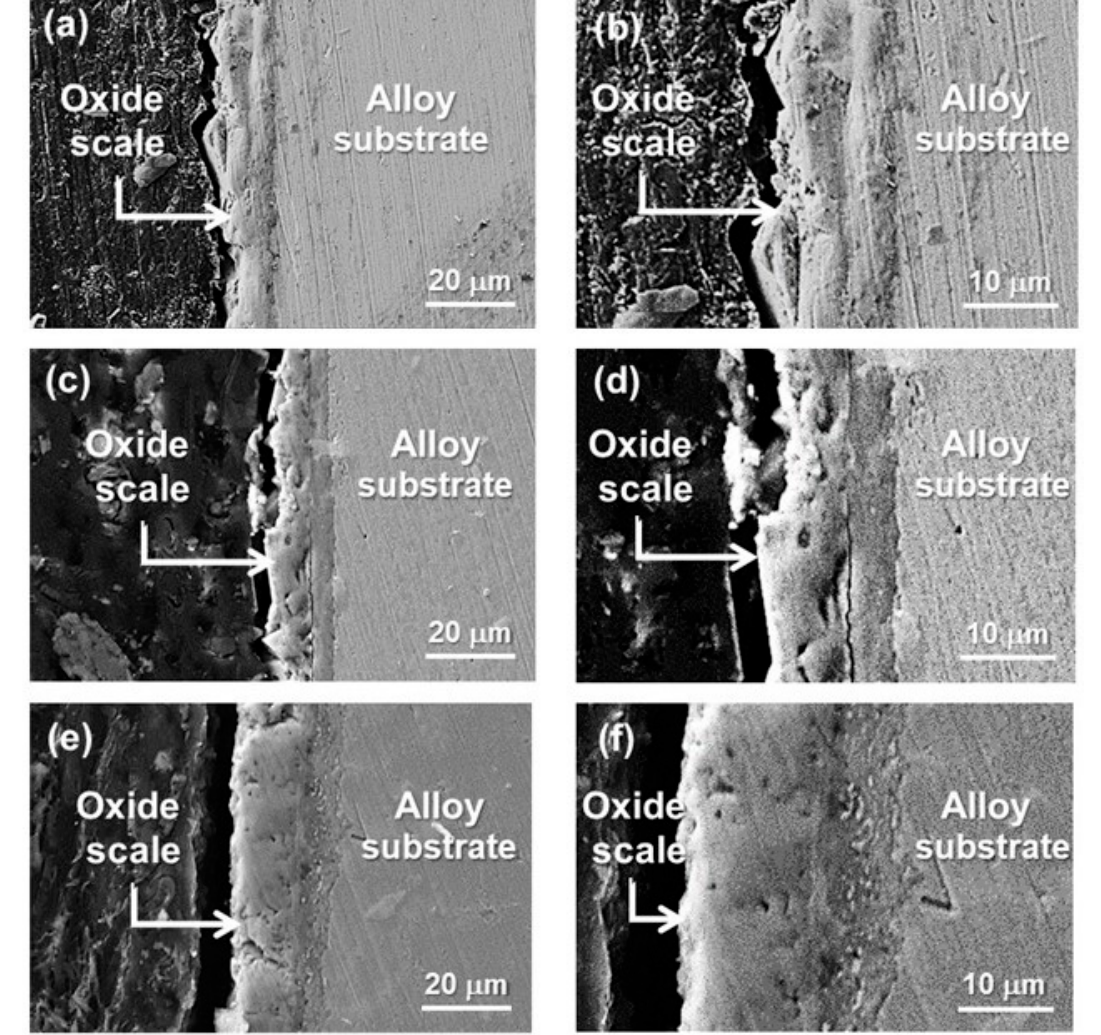
Figure 3. Cross-sectional SEM images of ( a , b ) SS301, ( c , d ) DS2205 and ( e , f ) DS2507 samples exposed to molten salts for 1000 h.